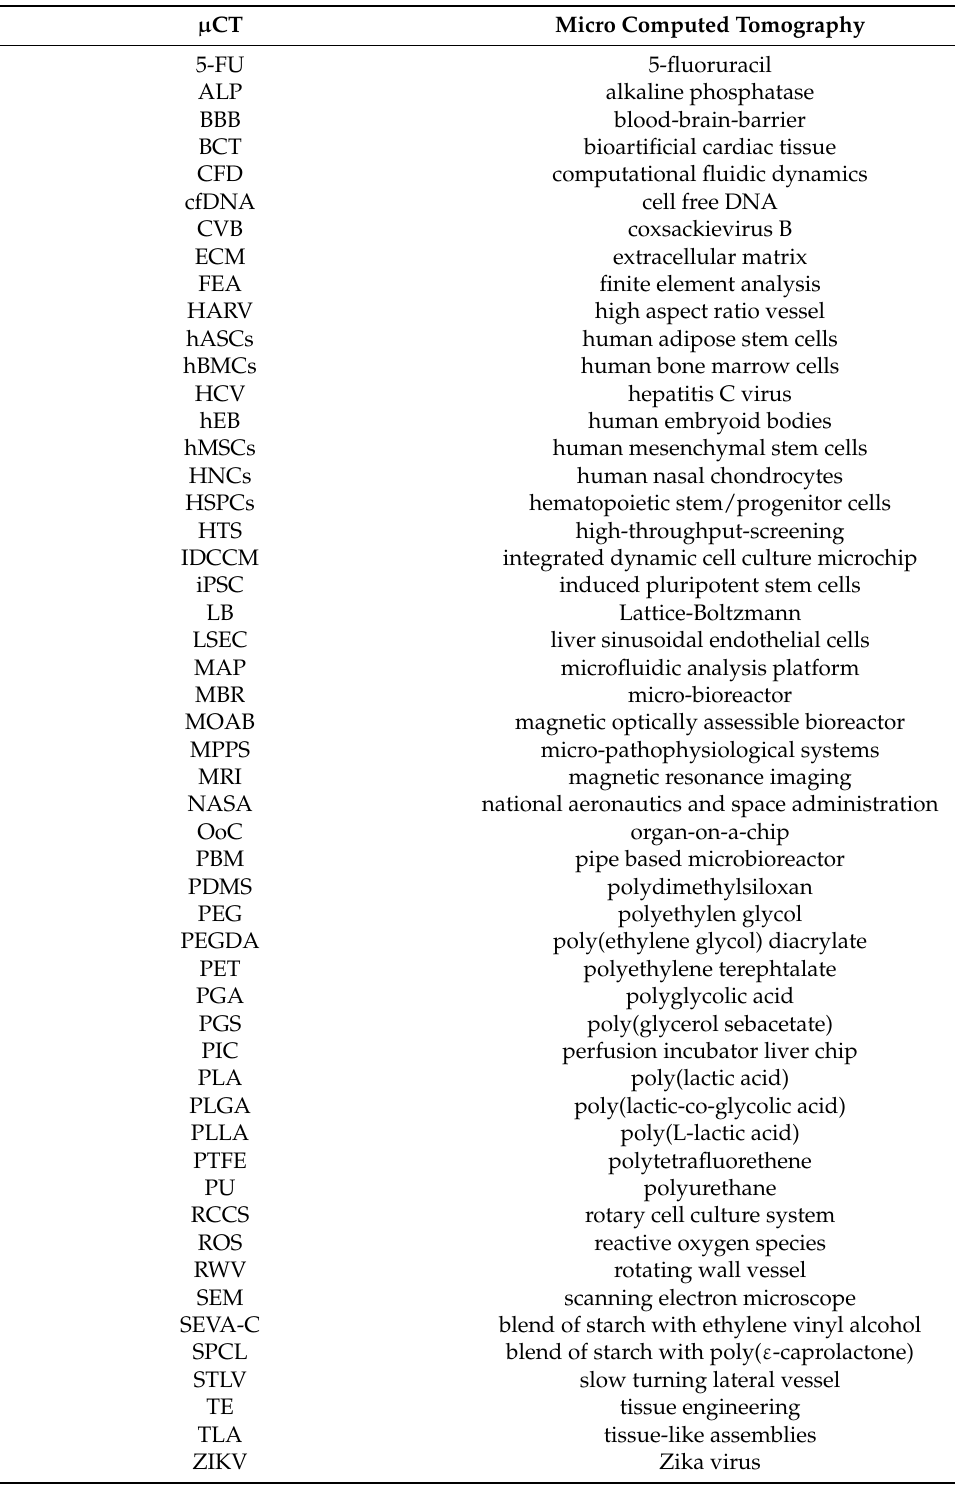
Table 1. Abbreviations appearing in the